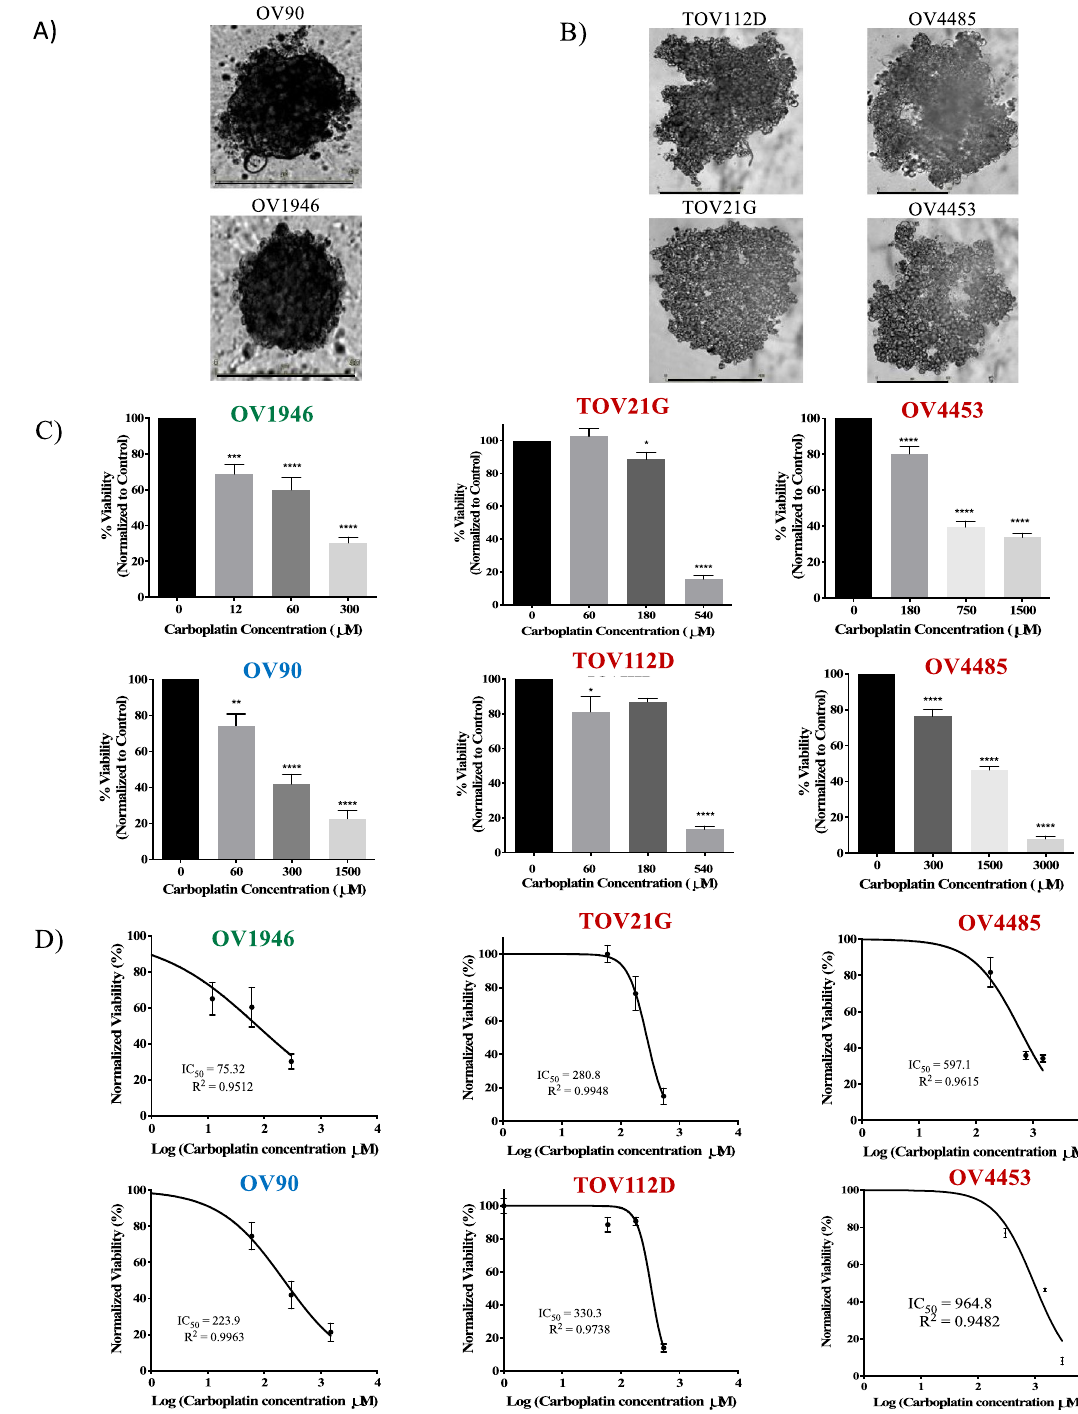
Figure 3. Carboplatin response of EOC 3D spheroids. Representative pictures of EOC cell lines forming at 48 h ( A) compact spheroids or ( B) dense aggregates. ( C) Normalized viability of spheroids after a 24-h carboplatin treatment with a 24-h recovery. ( D) Dose-inhibition response curves with their corresponding IC 50 . Sensitive cell lines are indicated in green fonts, intermediate in blue and resistant in red. Data are the mean ± SEM of three independent experiments, two replicates per condition. Scale bar on images ( A , B ) = 400 µm, * p < 0.05, ** p < 0.01, *** p < 0.001, **** p <